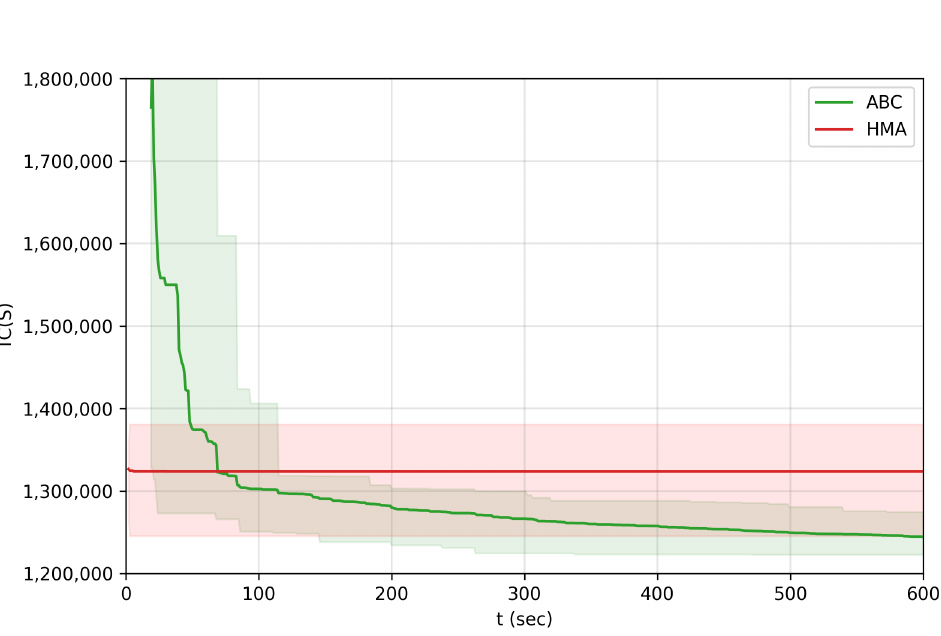
Figure 10. The convergence speed of 30 independent runs of HMA, and ABC algorithm on the “egl-g1-A” instance, plotted on one chart with time limit ( t ≤ 600 s)